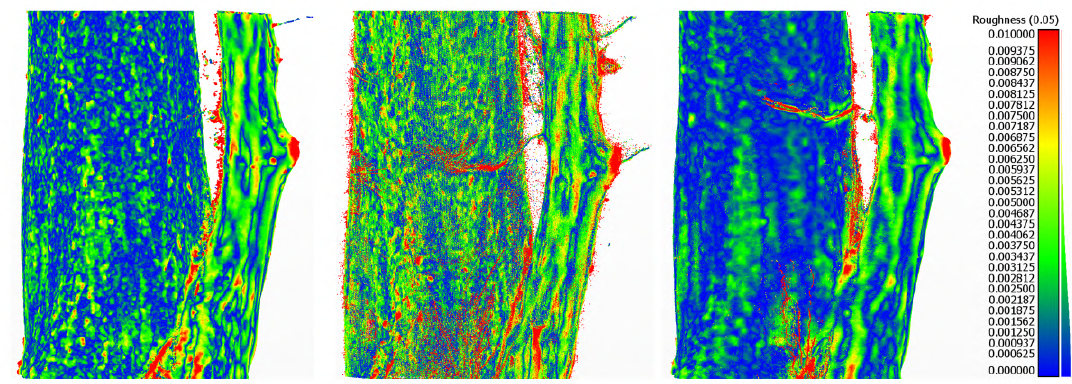
Figure 5. Point cloud of tree trunks generated with photogrammetry: (left) Root Buttress cavity, (middle) Liana and (right) Cavity.